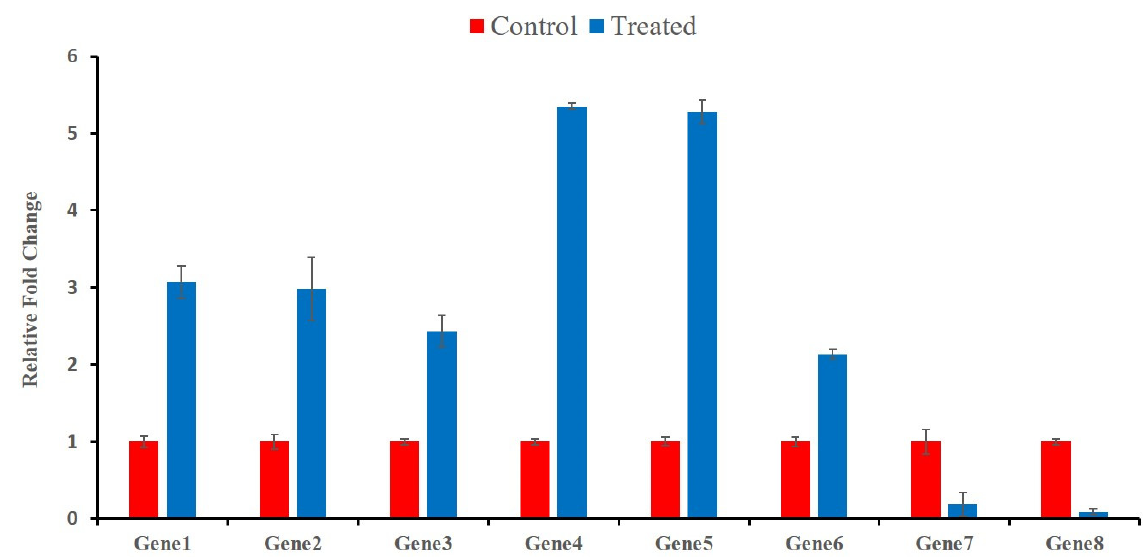
Figure 9. qRT-PCR validation results. The abscissa shows the genes’ ID and the ordinate shows the fold change. Quantification of gene expression was performed by the comparative 2 − ∆∆ CT method. The error bars indicate the standard deviations of the three independent qRT-PCR biological replicates. Gene1 refers to TraesCS7A02G468500, Gene2 refers to TraesCS7A02G173900, Gene3 to TraesCS5A02G272800, Gene4 to TraesCS2A02G032200, Gene5 to TraesCS2A02G032100, Gene6 to TraesCS2D02G073900, Gene7 to TraesCS2B02G184400 and Gene8 to TraesCS5D02G004400.